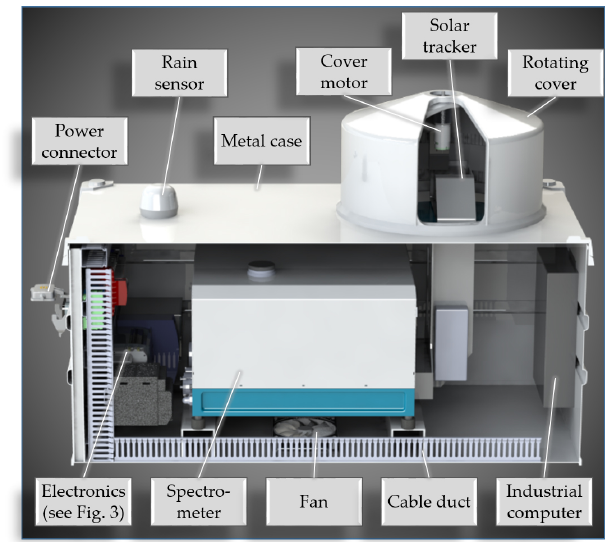
Figure 2. Side view of the enclosure system (CAD model).